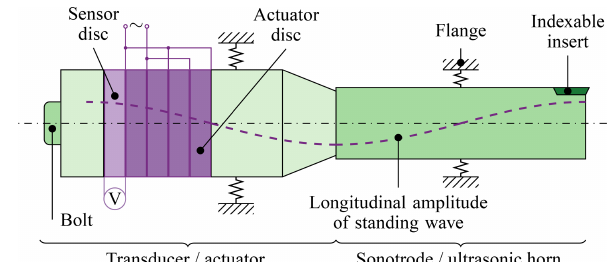
Figure 1. The general structure of active tool holders used for ul- trasonic vibration-assisted turning. Special features of the set-up utilized are the additional sensor discs within the transducer and a flange in the middle of the sonotrode, which increase bending stiff-